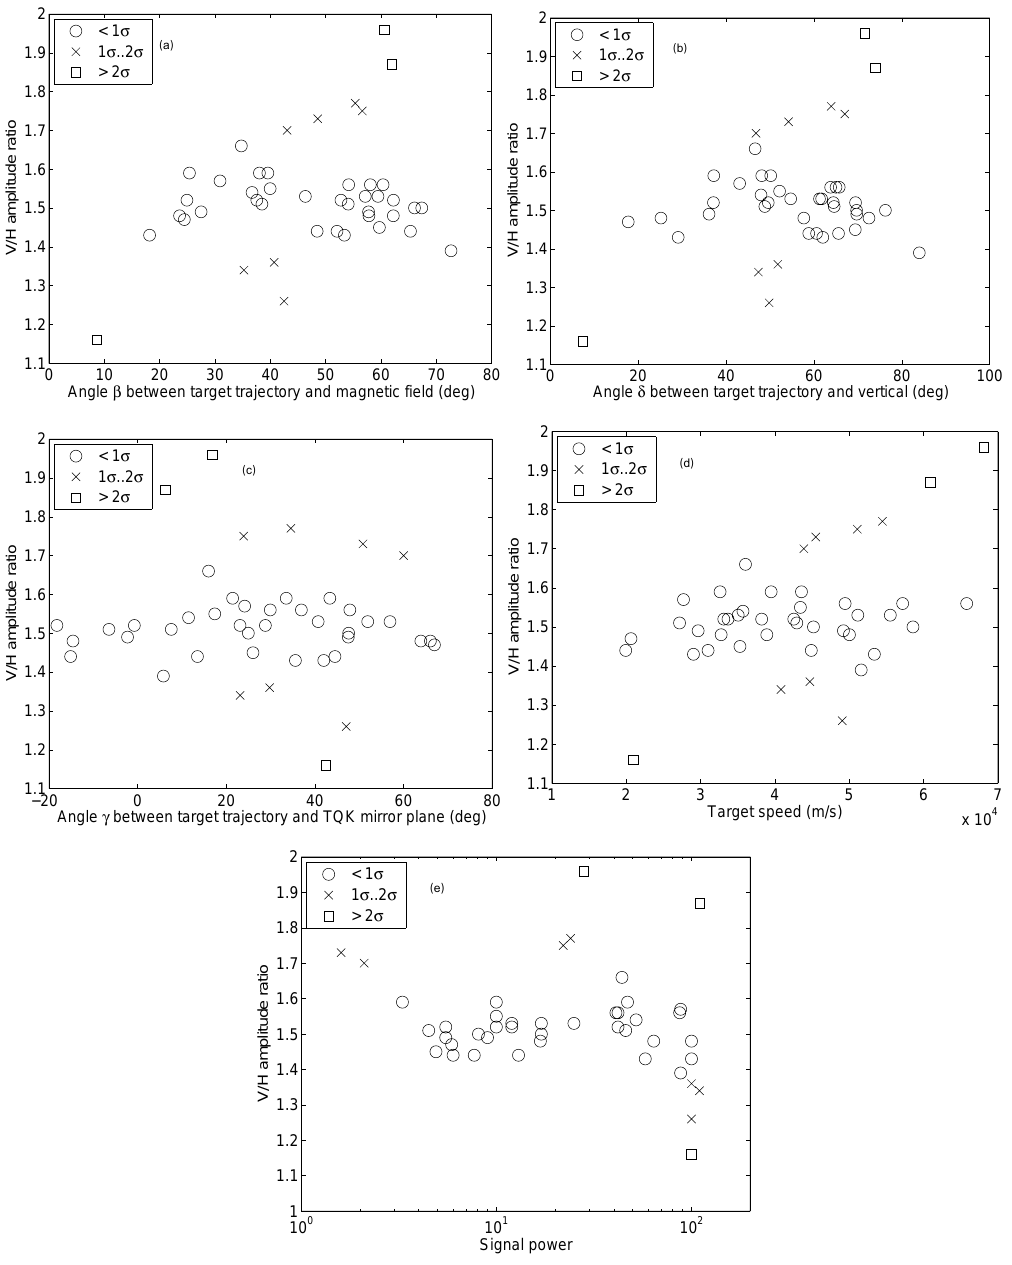
Fig. 5. Scatter plots of the relationships between the V/H amplitude ratio ρ and five other derived target parameters, viz. (a) the angle β between target trajectory and magnetic field, (b) the angle δ between target trajectory and vertical, (c) the angle γ between target trajectory and the TQK mirror plane, (d) the target speed v and (e) the peak signal power P